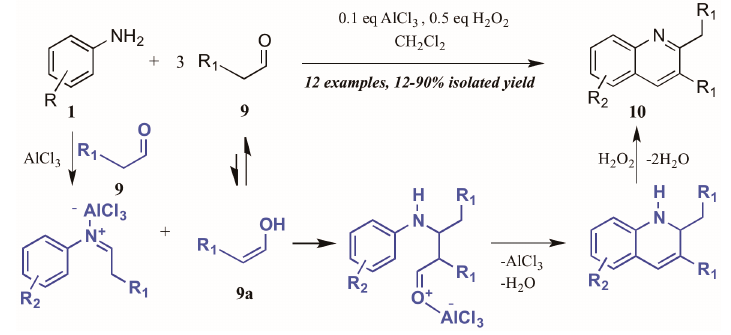
Figure 7. Doebner reaction using hydrogen peroxide as oxidant with Lewis acid catalyst.